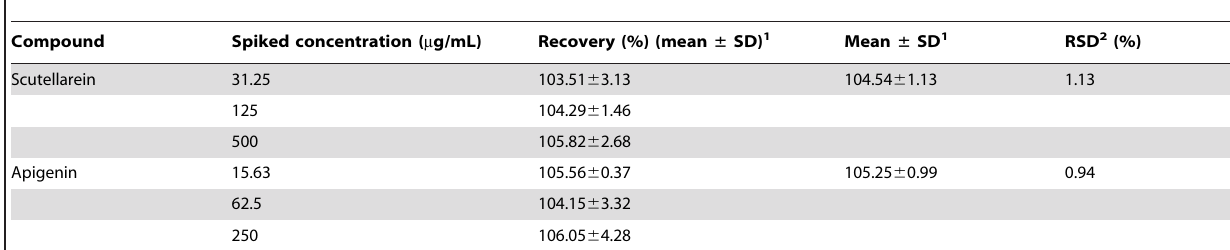
Table 4. Results of the recovery test for scutellarein and apigenin from the extract of A. chica .